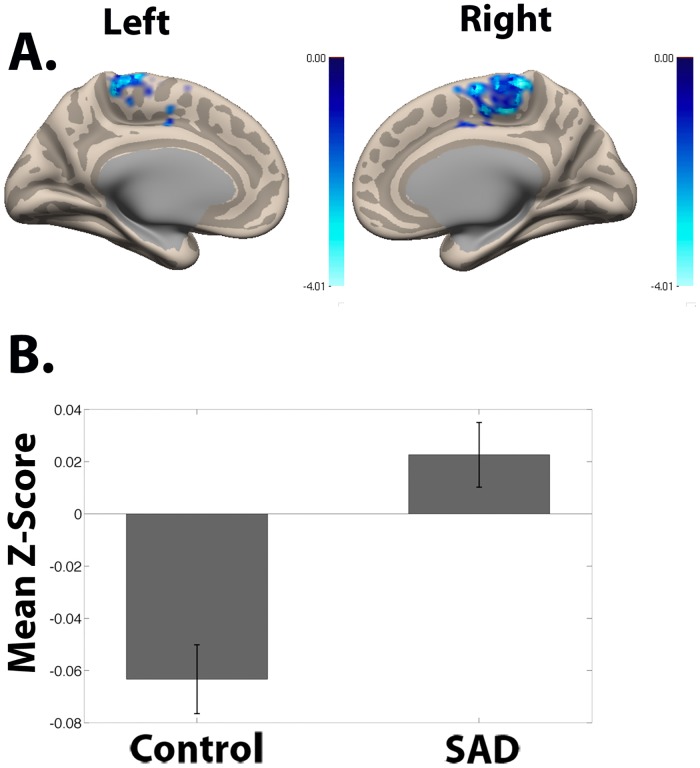
Nucleus Accumbens Seed Functional Connectivity Network of SAD > Control and Z-Scores.
(A) Resting-state connectivity for SAD group > Control group with bilateral nucleus accumbens seed from Fig 1 (Cluster-wise FDR corrected, p < .05; Peak voxel: (MNI Coordinates) (0, -34, 64; p = .006). (B) Mean Fisher transformed correlation values for resting-state connectivity for cluster from Fig 5A showing significant difference for SAD group > Control group with bilateral nucleus accumbens seed from Fig 1. Peak voxel (MNI coordinates): (0, -34, 64). Bars represent the mean connectivity among for each group for the ventromedial prefrontal cluster from Fig 5A. One-sample t-test relative to 0: Control: p < .0001; SAD: p = .07. Error bars represent standard errors.